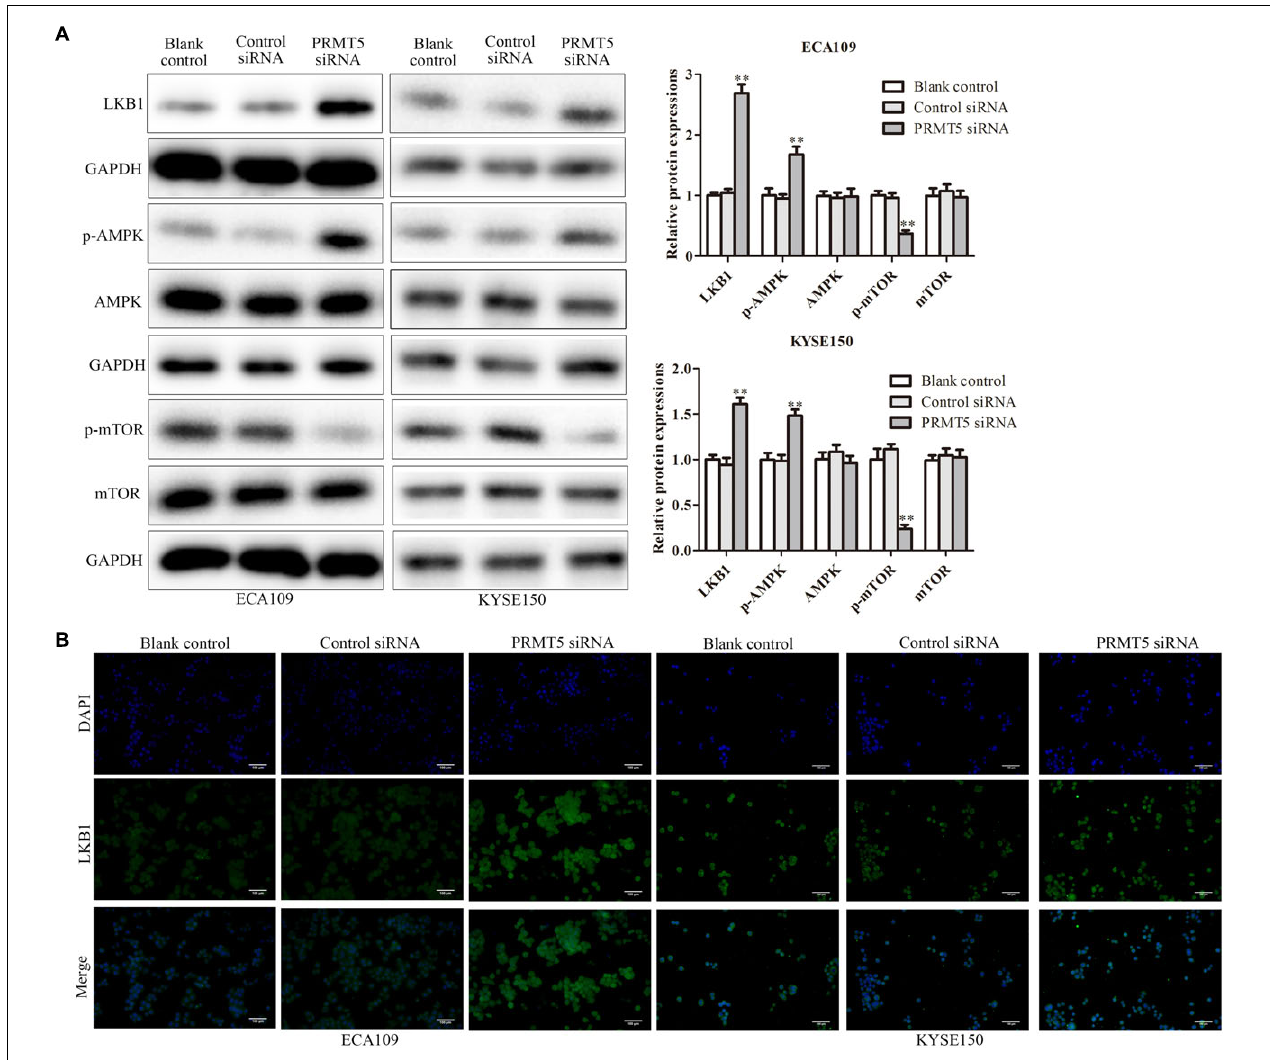
FIGURE 5 | PRMT5 activated LKB1/AMPK/mTOR signaling pathway. (A) The expression levels of LKB1, AMPK, p-AMPK, mTOR, and p-mTOR were analyzed in ECA109 and KYSE150 cell lines. GAPDH was used as a control. (B) Immunofluorescence was used to determine the expression level of LKB1 in ECA109 and KYSE150 cell lines. Bars indicate the mean ± SEM, * P < 0.05, ** P < 0.01 vs. control siRNA; magnification × 200. PRMT5, protein arginine methyltransferase 5; LKB1, liver kinase B1; AMPK, adenosine monophosphate kinase; mTOR, mammalian target of